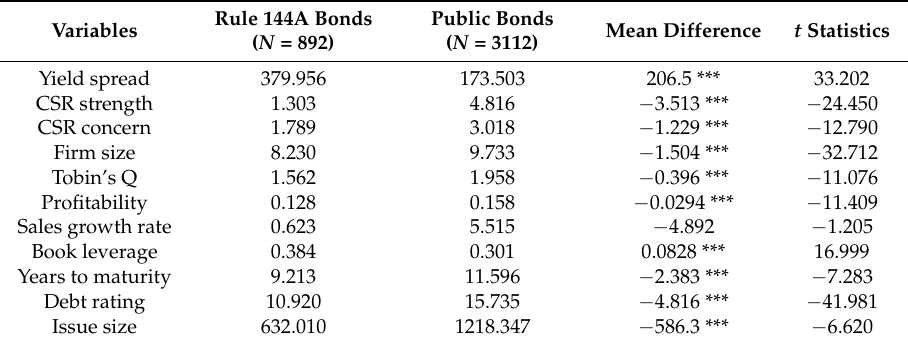
Table 2. Univariate